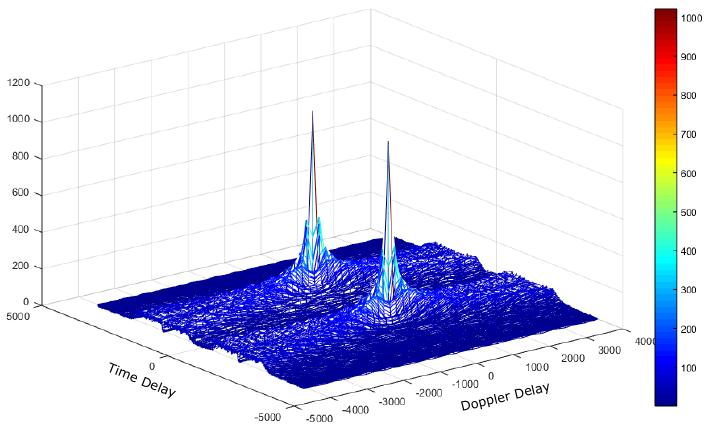
Figure 16. Two nearby scatterers using chirp pulses (multidimensional, multi-component, polynomial phase (MMPP)) with no